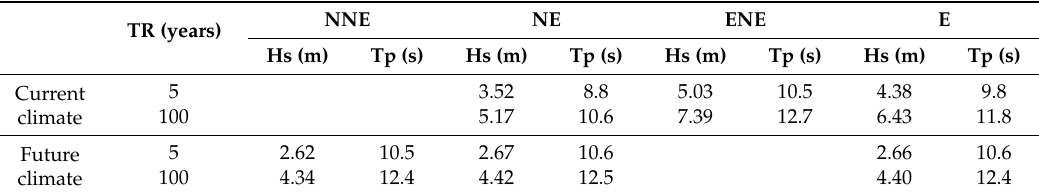
Table 2. Wave height and peak period data corresponding to current and future climate